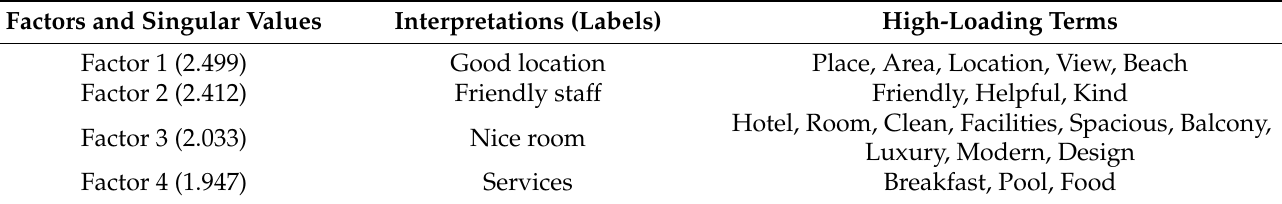
Table 2. Factors regarding customer satisfaction.